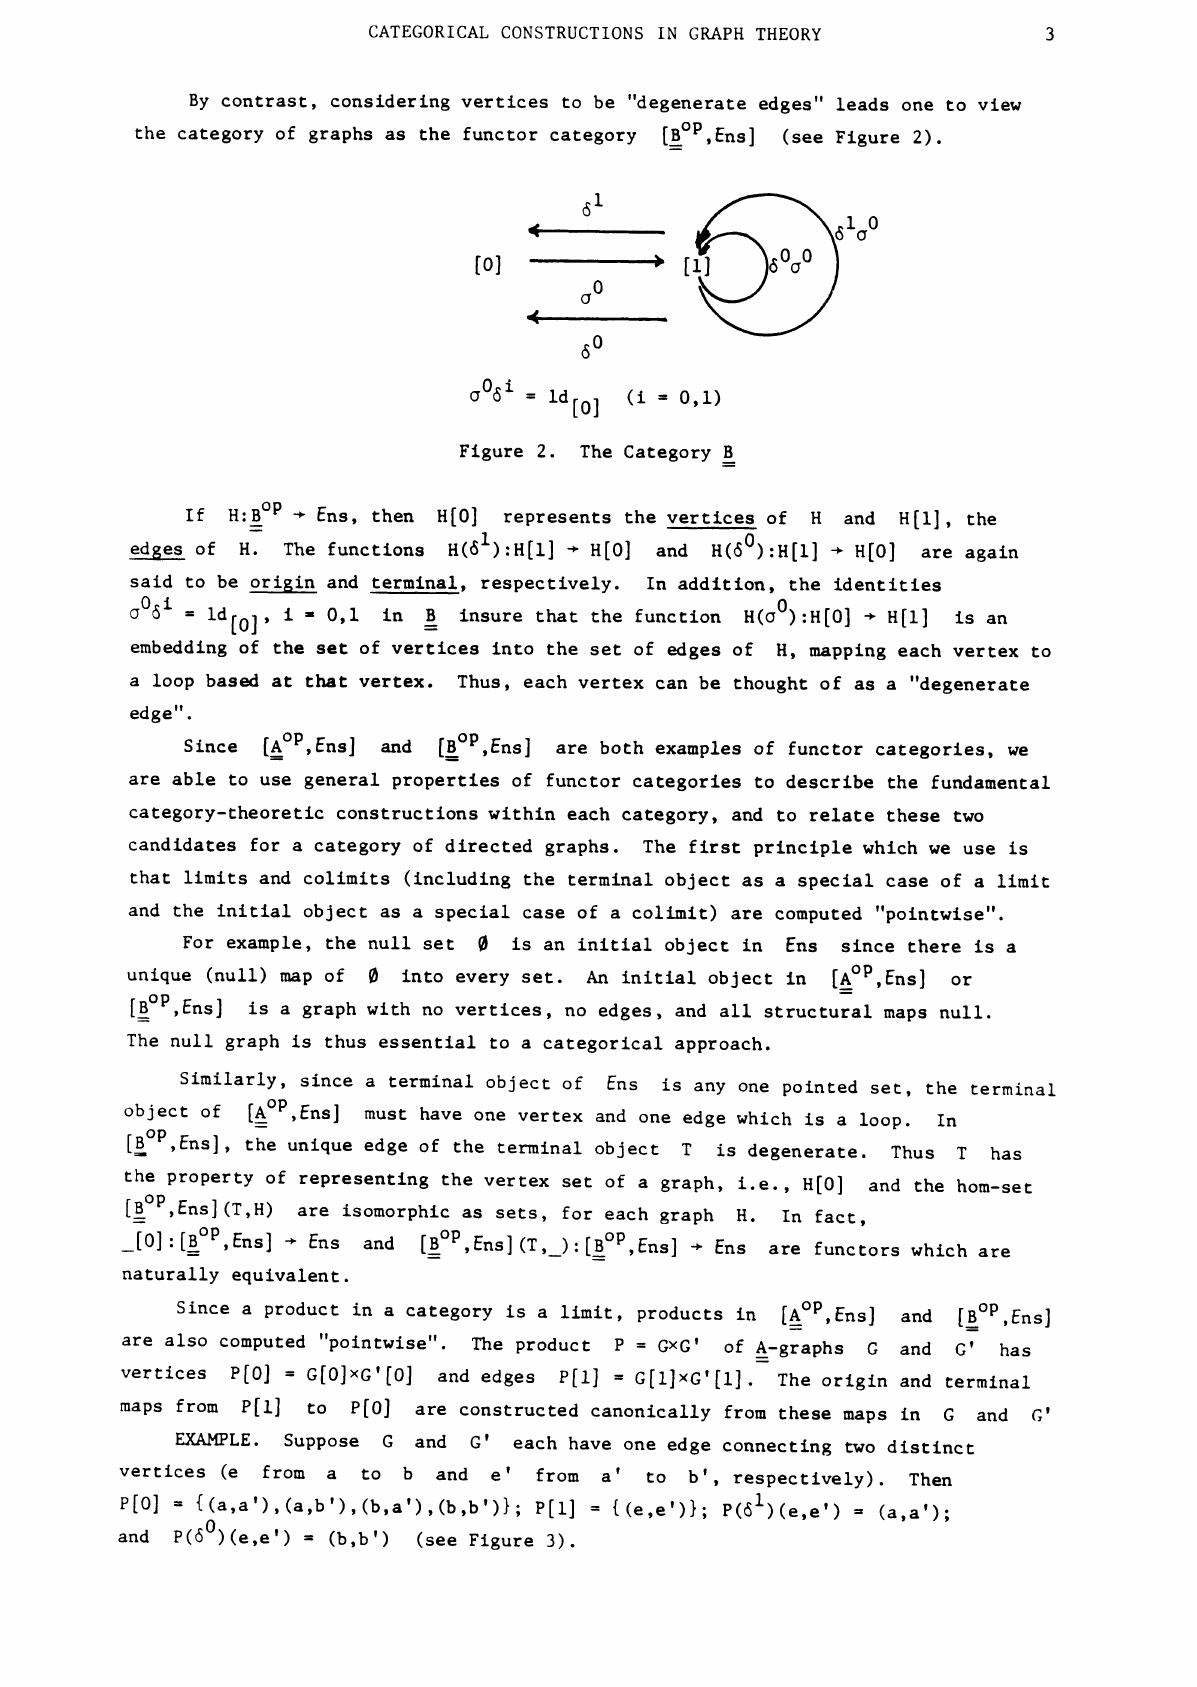
Figure 2. The Category